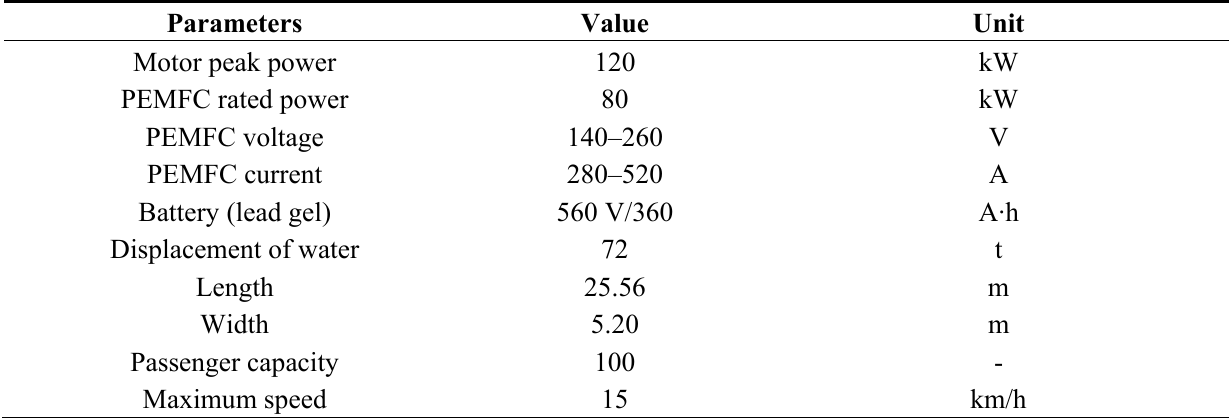
Table 1. Parameter of the fuel cell (FC) boat (data extracted from [6]). PEMFC: proton exchange membrane fuel